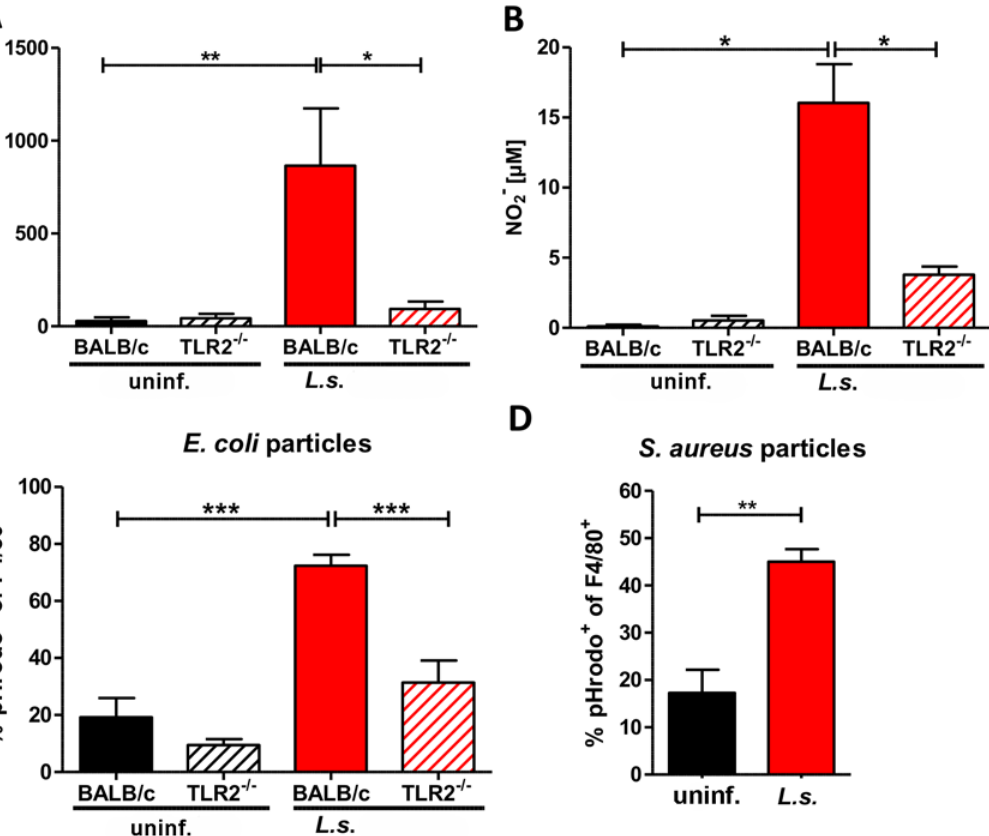
Figure 7. Anti-bacterial effector mechanisms are enhanced by L. sigmodontis infection in a TLR2 dependent manner. ( A ) Colony forming units (cfu) obtained by a gentamycin assay using peritoneal macrophages derived from chronic L. sigmodontis ( L.s. )-infected wild type and TLR2 -/- mice and respective uninfected controls three hours after i.p. E. coli injection. ( B ) Nitrite concentrations of the same macrophages as in ( A ) after ex vivo cultivation for 48 hours. Frequency of peritoneal F4/80 - positive macrophages from L.s.- infected and uninfected wild type and TLR2 -/- mice (n = 5 per group) that phagocytosed pHrodo E. coli -BioParticles 90 minutes post injection ( C ) or from L.s. -infected and uninfected wild type mice (n = 5 per group) that phagocytosed pHrodo S. aureus -BioParticles three hours post injection ( D ). ( A ) Pooled data from two independent experiments with at least four mice per group. Data shown in ( A-C ) is illustrated as mean + SEM and was tested for statistical significance by 1-way ANOVA followed by Dunn ’ s multiple comparisons test; Data in ( D ) is also shown as mean + SEM and was tested for statistical significance by Mann-Whitney U test. * p < 0.05; ** p < 0.01; *** p <